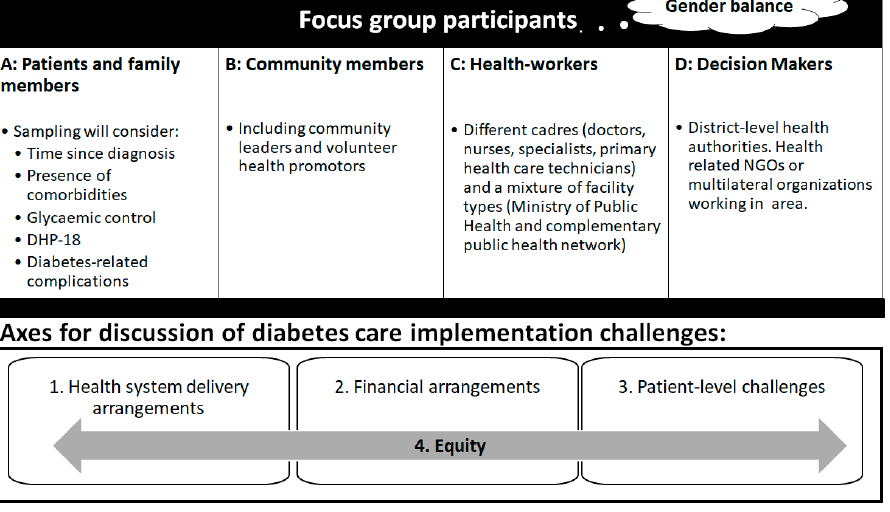
Figure 2. Purposive selection criteria for focus group participants and axes for discussion of diabe- tes care implementation